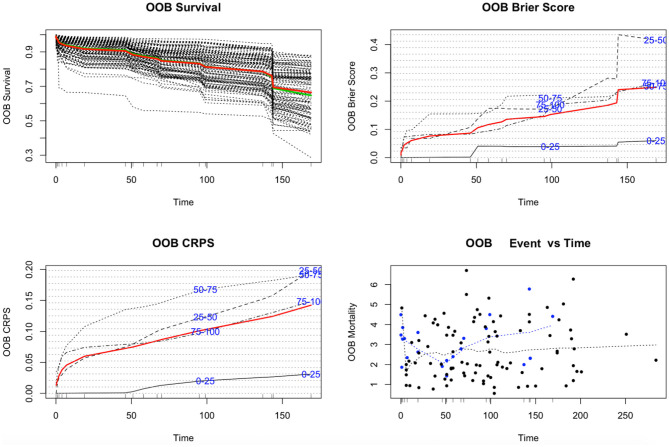
Survival estimates. Survival function estimated for each LQTS patient from the random survival forest (RSF) model (overall ensemble survival is indicated by the red line; the Nelson-Aalen estimator is given by the green line) (top left). Brier score (0 = perfect, 1 = poor, and 0.25 = guessing) stratified by ensemble spontaneous VT/VF based on the inverse probability of censoring weight (IPCW) method (top right). The cohort was stratified into four groups of 0–25, 25–50, 50–75, and 75–100 percentile spontaneous VT/VF (the overall, non-stratified, Brier score is shown by the red line). Continuous rank probability score (CRPS) given by the integrated Brier score divided by time (bottom left). Plot of spontaneous VT/VF of each LQTS patient against time (bottom right). Events are shown as blue points, whereas censored observations are shown as black points.